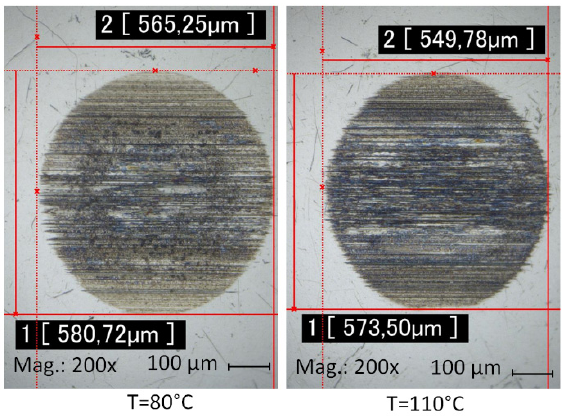
Figure 8. Wear scar images on the ball specimen surfaces with the oil sample number 1 (2-hour running time) on 80 (left) and 110°C (right) (pictures of the